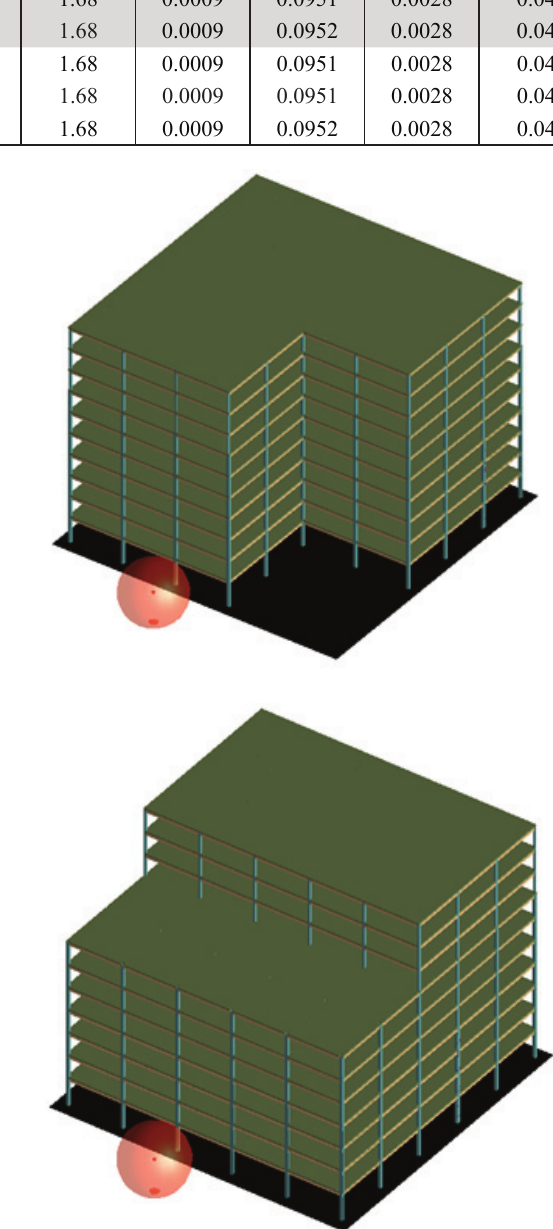
Fig. 3. Blast location 1 – typical for MRF, CBF, EBF Fig. 4. Blast location 2 – typical for MRF, CBF,